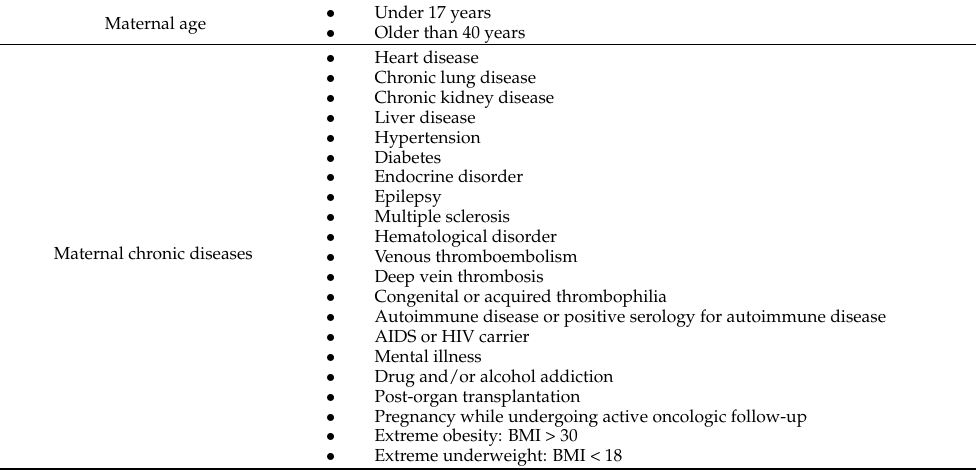
Table A1. High-risk pregnancy